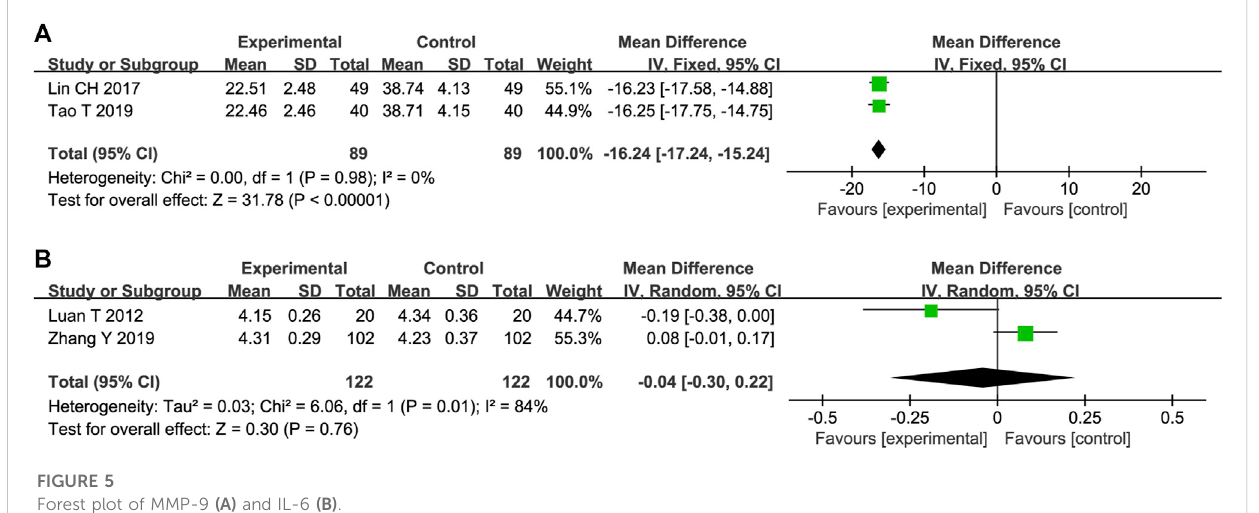
FIGURE 5 Forest plot of MMP-9 (A) and IL-6 (B)